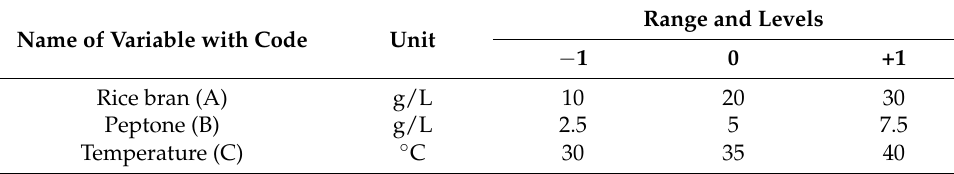
Table 1. Variables optimized by CCD for PHB production.